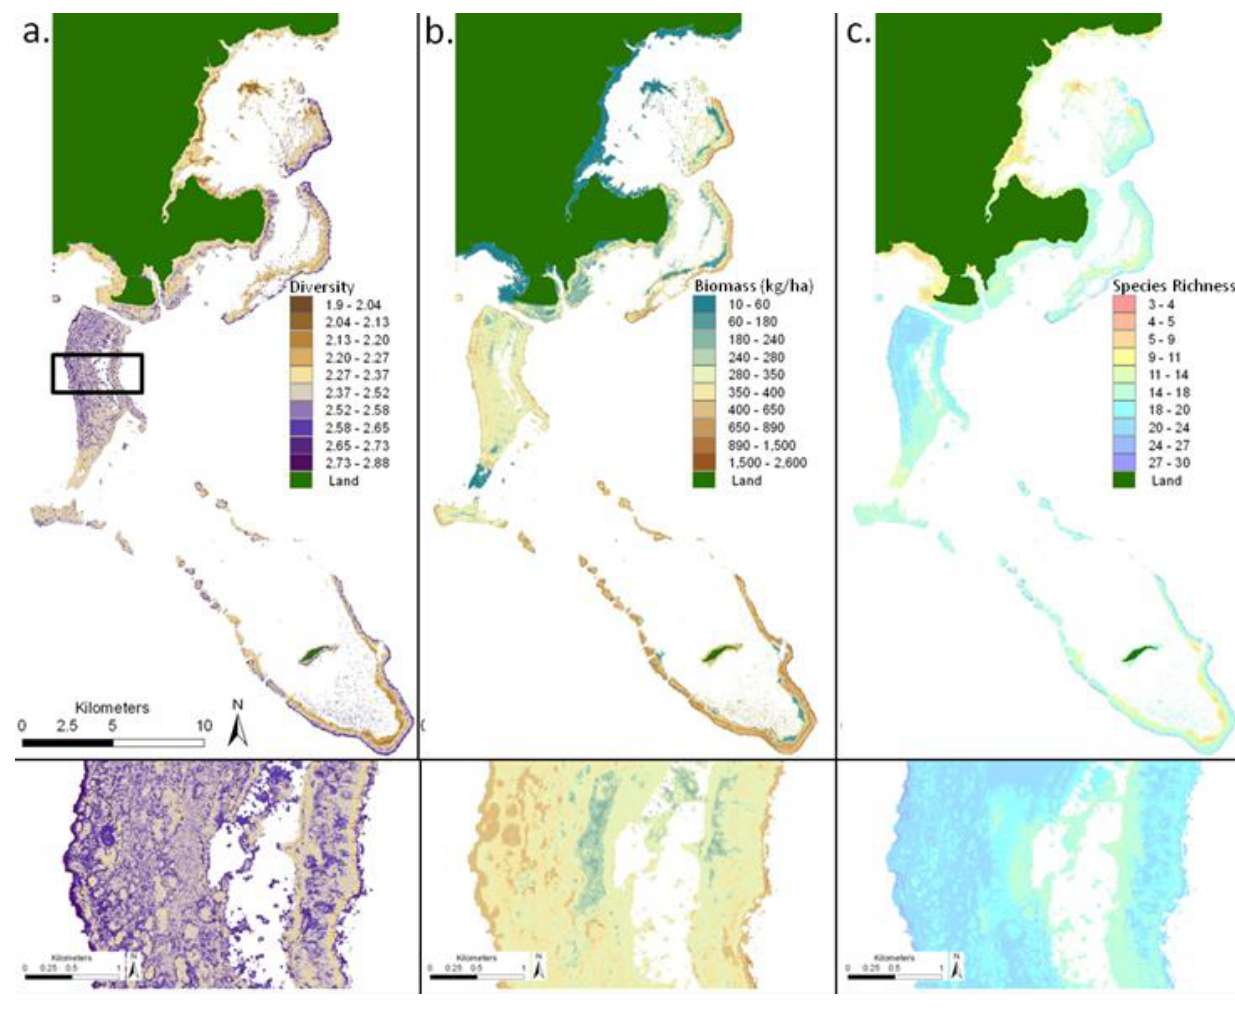
Figure 5. Predictions of the three fish response variables: ( a ) Shannon diversity, ( b ) biomass, and ( c ) species richness. Subset areas are outlined by the black box in (a), and correspond to those shown in Figure